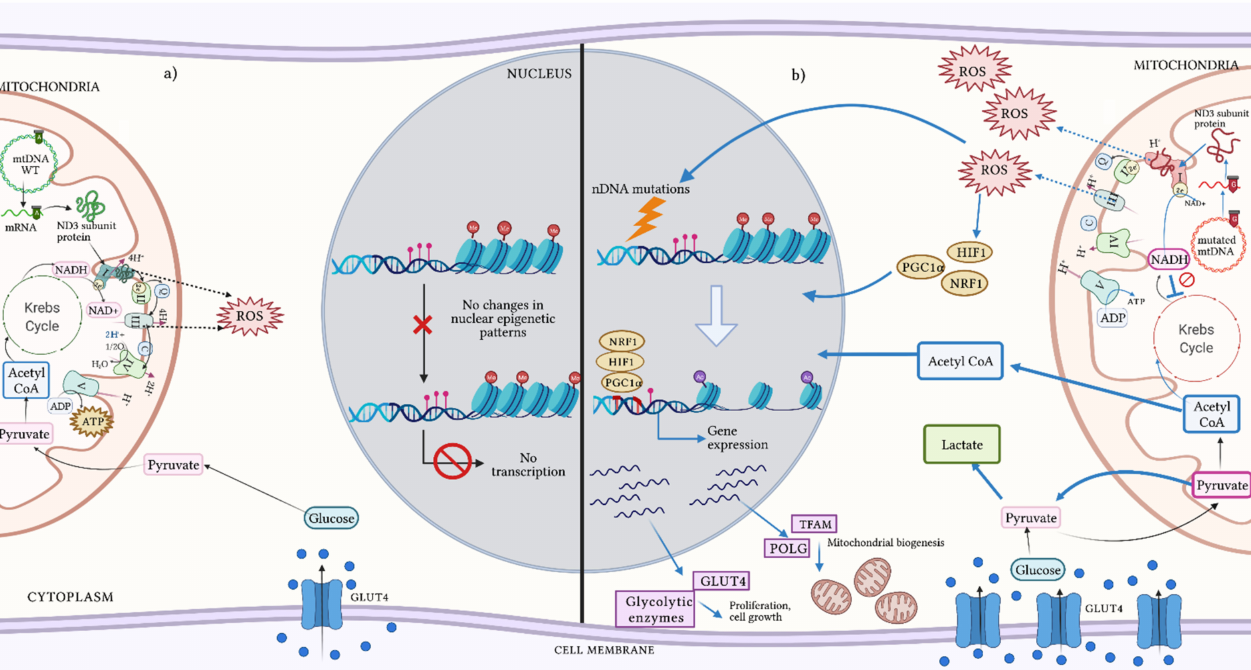
Figure 4. Crosstalk between mtDNA and nDNA. mtDNA codes for the most hydrophobic subunits of the OXPHOS system and the assembly of the complexes assembly is carried out in a perfectly coordinated manner between mtDNA and nDNA. ( a ) The appropriate function of the OXPHOS system maintains an efficient electron transfer and ATP synthesis that reduce NADH generated during glucose metabolism. ( b ) The presence of mtDNA mutations in coding regions can lead to the structural or functional alteration of protein subunits, resulting in an inefficient OXPHOS system and thus a high production of ROS. Dysfunction of the OXPHOS system inhibits the Krebs cycle and modifies the concentrations of important metabolites such as pyruvate and acetyl-CoA. These molecules alter the histone acetylation and mtDNA methylation levels. High concentrations of pyruvate, acetyl-CoA and ROS increase the acquisition of nDNA mutations and favor a hypoxic state that activates transcription factors such as HIF1, NRF1 and PGCa. These proteins increase the expression of genes involved in glycolytic metabolism and mitochondrial biogenesis processes, which have been associated with increased tumor growth and malignant cell proliferation. ADP: adenosine diphosphate; ATP: adenosine triphosphate; GLUT4: glucose transporter type 4; HIF1: hypoxia inducible factor 1; mRNA: messenger RNA; mtDNA: mitochondrial DNA; NAD+: nicotinamide adenine dinucleotide (oxidated form); NADH: nicotinamide adenine dinucleotide (reduced form); nDNA: nuclear DNA; NRF1: nuclear respiratory factor 1; OXPHOS: oxidative phosphorylation; PGC1 α : proliferator- activated receptor γ -coactivator 1 α ; POLG: DNA polymerase gamma; ROS: reactive oxygen species; TFAM: mitochondrial transcription factor A; WT: wild-type. Figure artwork created with